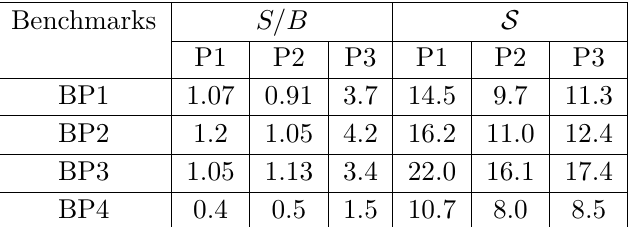
Table 5. S/B and signal significance ( S ) for different benchmark points for various beam polar- izations, P1, P2, P3 (see text). S has been calculated for L = 100 fb − 1